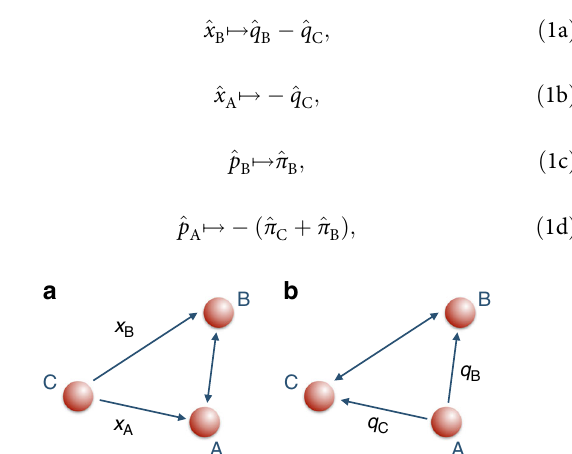
Fig. 2 Transformation to relative coordinates. a Relative position coordinates of A and B from the point of view of C. b Relative position coordinates of B and C from the point of view of A. It is immediate to verify ^ q ^ q ^ q that ^ x and that ^ x B 7! B (cid:2) C A 7! (cid:2)